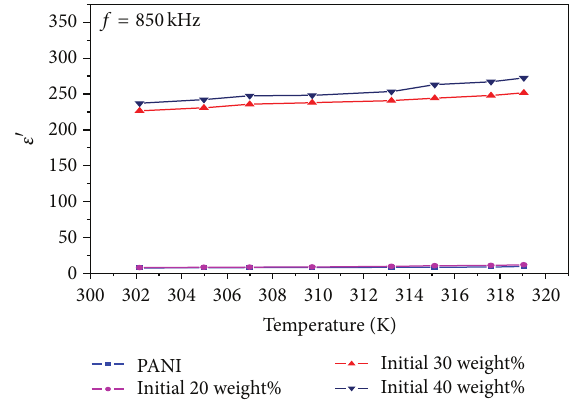
Figure 2: Dielectric constant ( 𝜀 󸀠 ) versus temperature at fixed fre- quency for pure polyaniline and PANI/V 2 O 5 composites (different weight %).